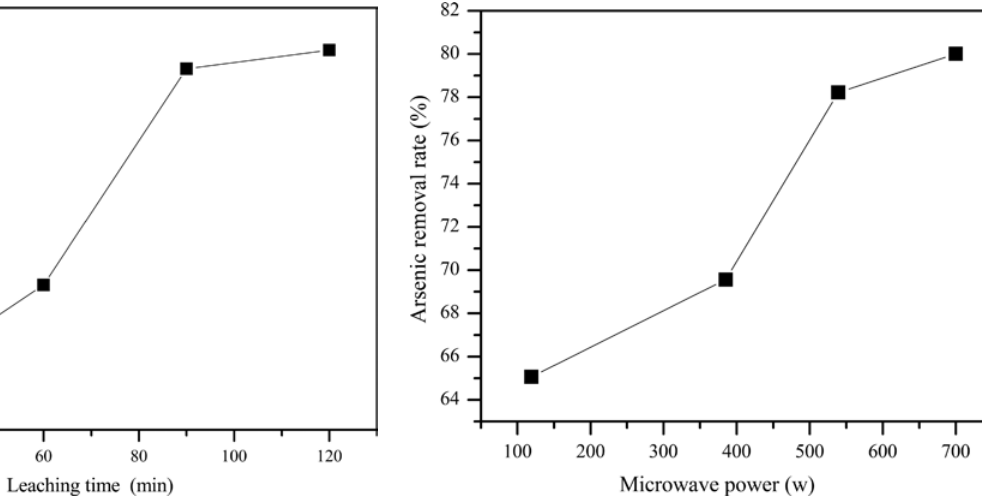
Figure 4: Effect of leaching time on arsenic removal rate. Figure 5: Effect of microwave power on arsenic removal